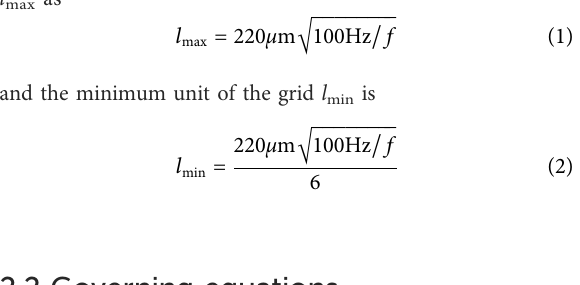
the cavity ABH model with the maximum unit of the grid